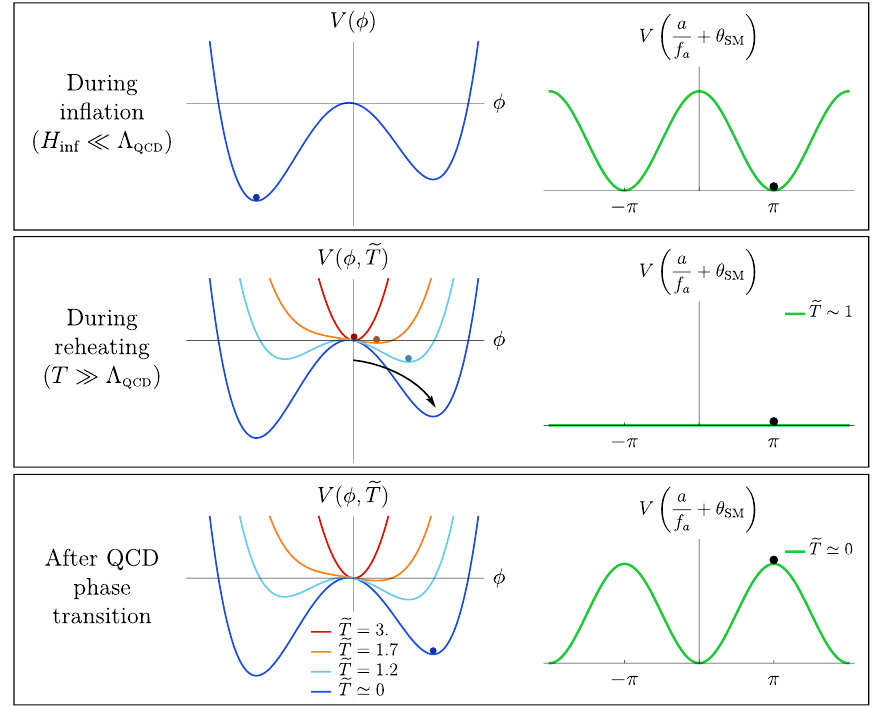
Figure 3 . Figure analogous to (cid:12)gure 1, for the case in which (cid:30) lies in its true vacuum during in(cid:13)ation and ends up in the false vacuum today. For visualisation purposes, the Yukawa coupling y is